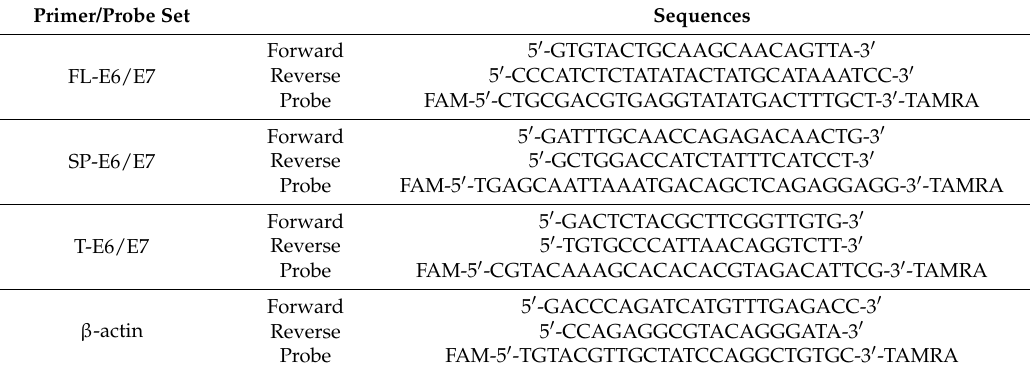
Figure 1. Characteristics of E6/E7 mRNA species amplified in the E6/E7 quantitative reverse transcription polymerase chain reaction (qRT-PCR) assay. Table 2. Sequence-specific oligonucleotide primers and probes used for quantification of HPV16 E6/E7 mRNA VL by quantitative reverse transcription polymerase chain reaction